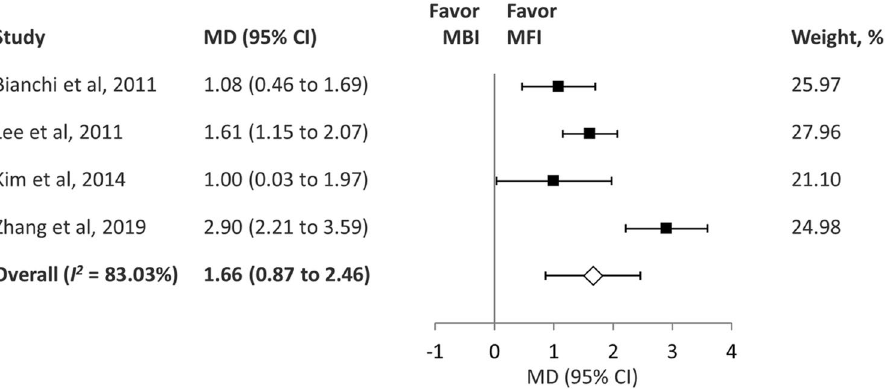
Figure 2. Forest plot of cosmetic satisfaction after parotidectomy. MD mean difference, CI confidence interval, MBI Blair incision, MFI modified facelift